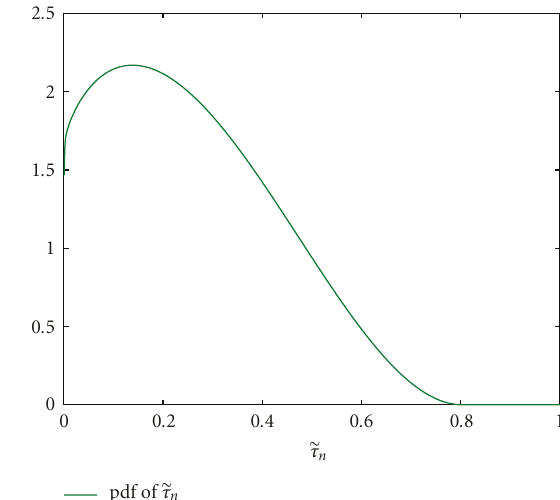
Figure 9: Analytical plot of f (cid:9) τ